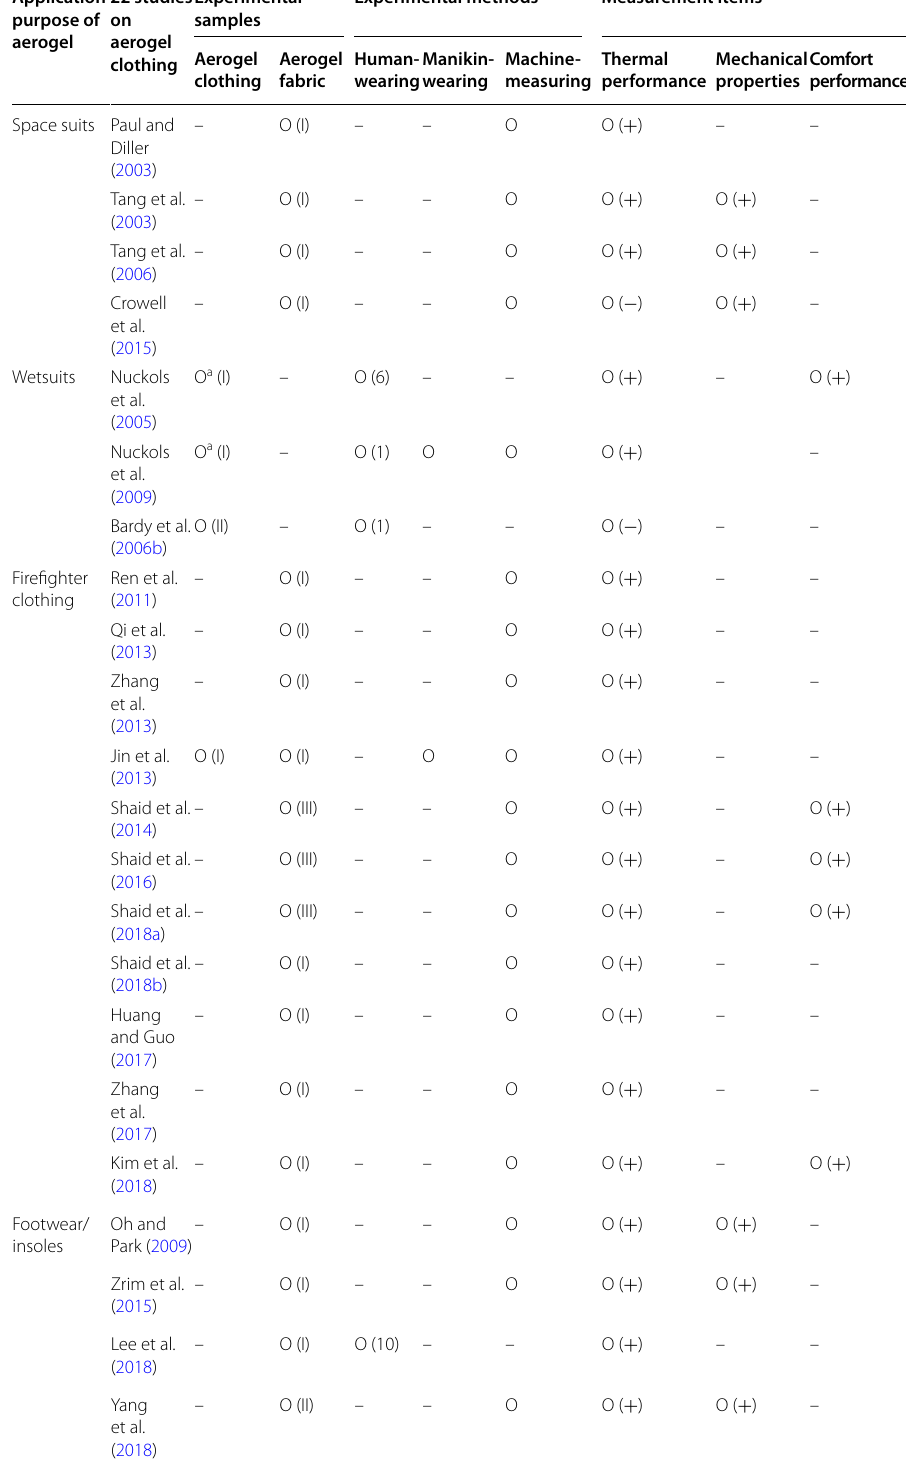
Table 3 Methodology for the evaluation of the performance of aerogel clothing Application 22 studies purpose of aerogel